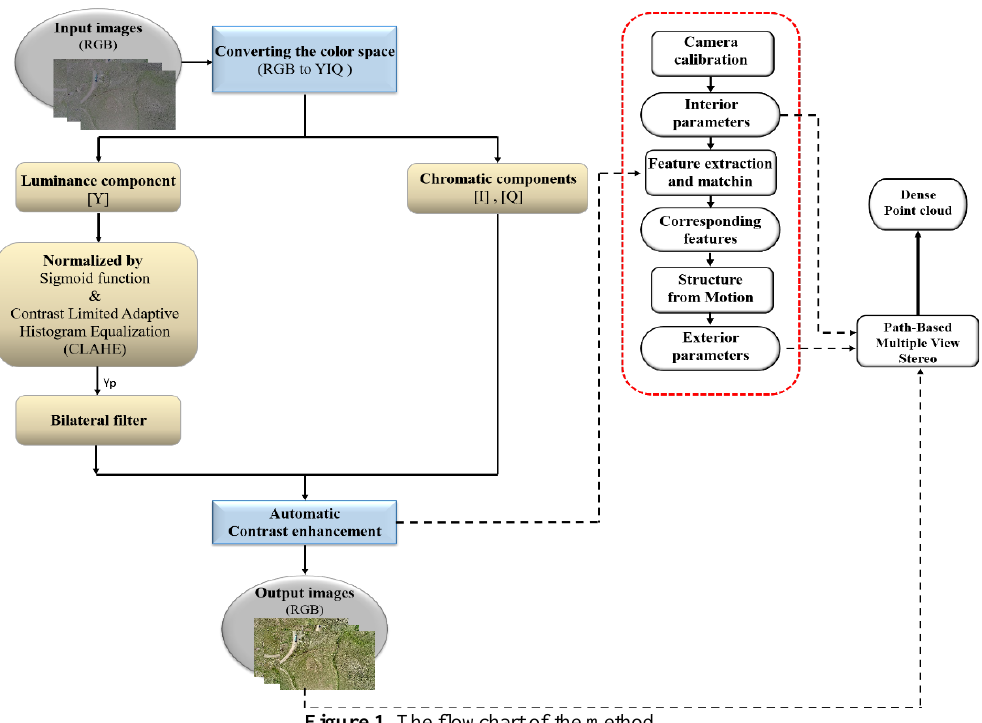
Figure 1 . The flowchart of the